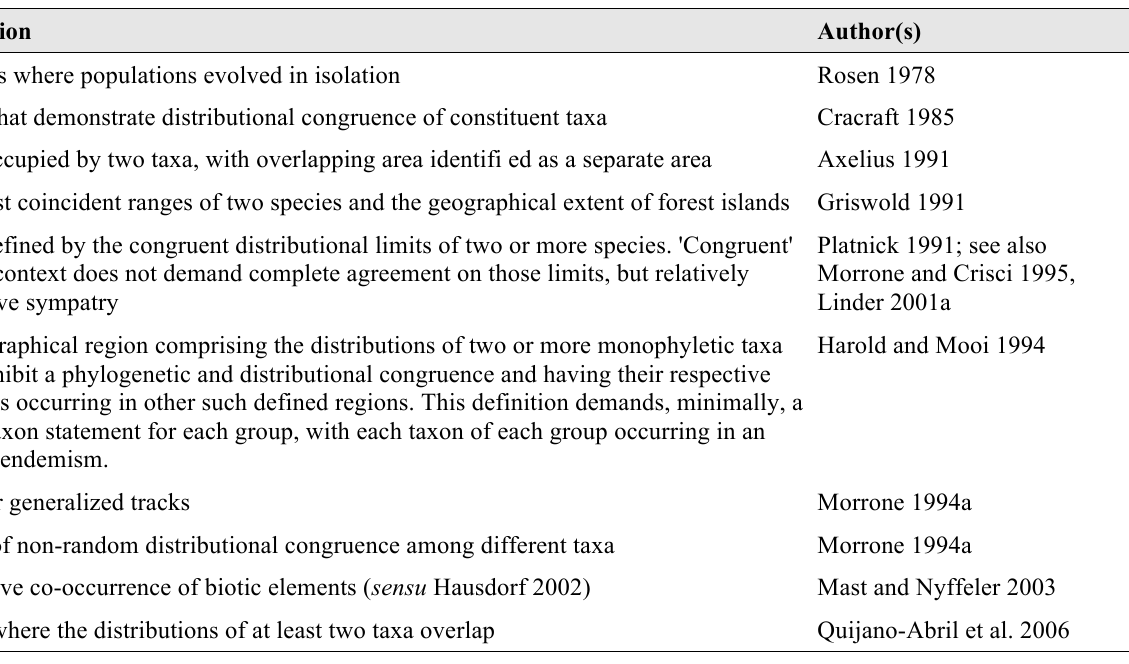
Table 2. Definitions of area of endemism (modified from Parenti and Ebach